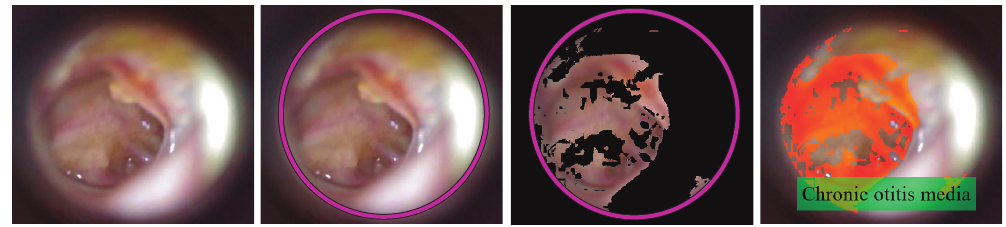
Fig 11. Chronic otitis media case: If the system classified the RGB input image as chronic otitis media disease, the system highlights the perforated area denoted by red color. From left to right: RGB input image, region of interest, chronic otitis media segmentation and area under medical suspicion